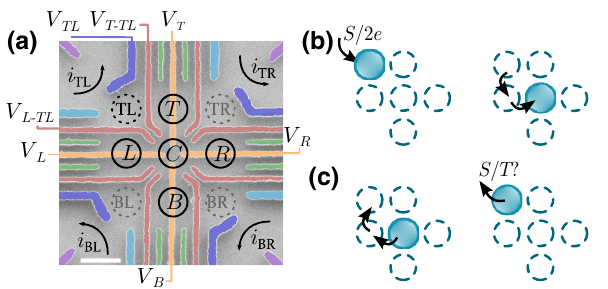
FIG. 1. The sample and spin loading and readout sequence. (a) An electron micrograph of a sample similar to the one used in this work. The nine circles indicate the 3 × 3 array of quan- tum dots (QDs) arising from the gate-induced potential landscape (see text). The five dots L , B , R , T , and C in a crossbar con- figuration (solid circles) are used for the coherent electron spin shuttling in two dimensions. The square lattice of QDs is electro- statically defined due to the red gate voltages and its outer edges by the green, light blue, and blue gate voltages. The couplings of the array to electron reservoirs are achieved through the cor- ner QDs TL, BL, BR, and TR and by controlling the light blue and blue gates. The purple gates are used to define four quantum point contacts operated as local electrometers, the conductances of which set the measured currents i TL, BL, BR, TR . The scale bar (white) is 200 nm. (b),(c) Schematics of the sequence used to load a singlet spin in C (b) and to read out the final spin state after manipulation (c).